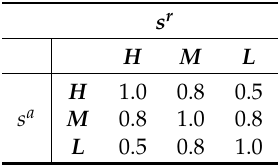
Table 1. The score matching function sm